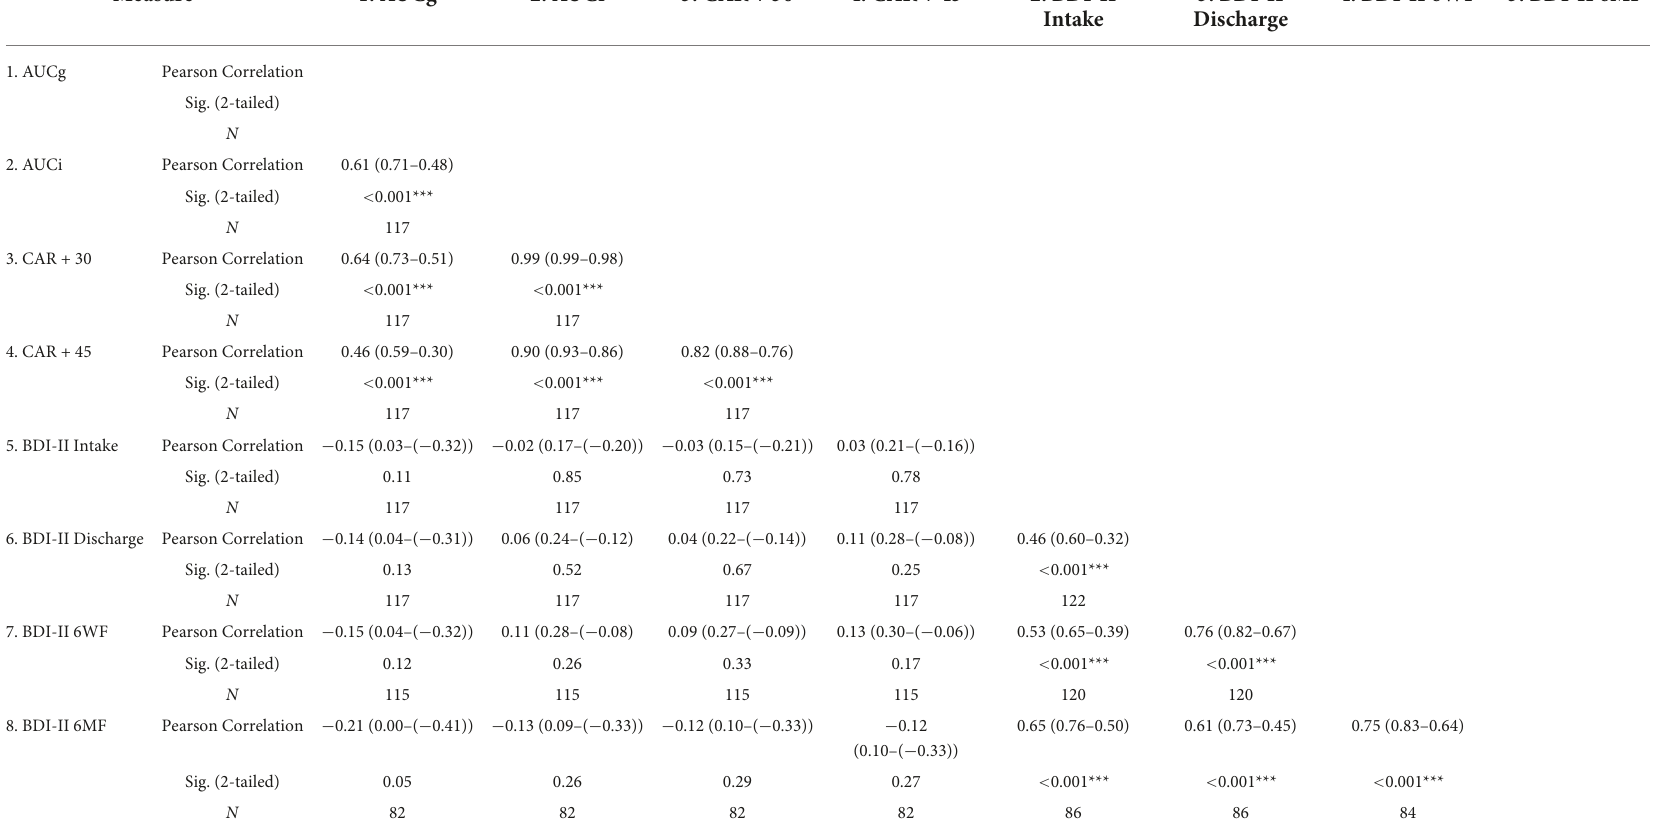
Two-tailed95%confidenceoccurinbracets.M,mean;BDI-II,BeckDepressiveInventoryII;WF,weekfollow-up;MF,monthfollow-up;AUCi,areaunderthecurveincrease;AUCg,areaunderthecurveground.* p < 0.05,** p < 0.01,*** p <